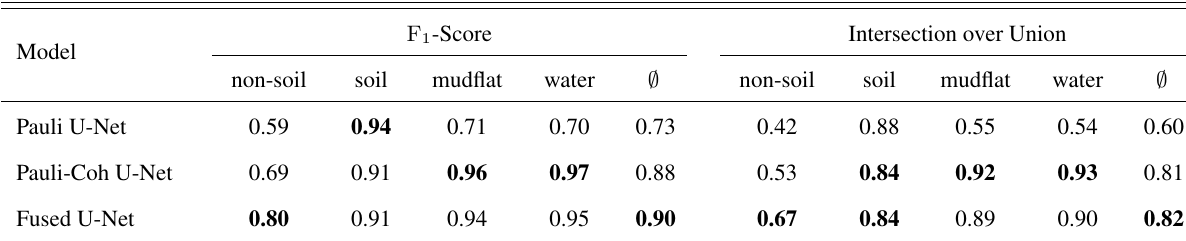
Table 2. Class-wise and average F 1 -Scores and Intersection over Union (IoU) for classification of test data achieved by the